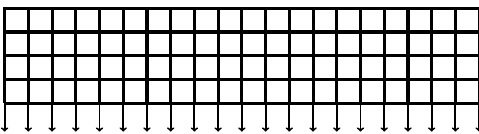
Figure 14. The vertical displacements, indicated with arrows, of the bottom nodes as the QoI for model problem